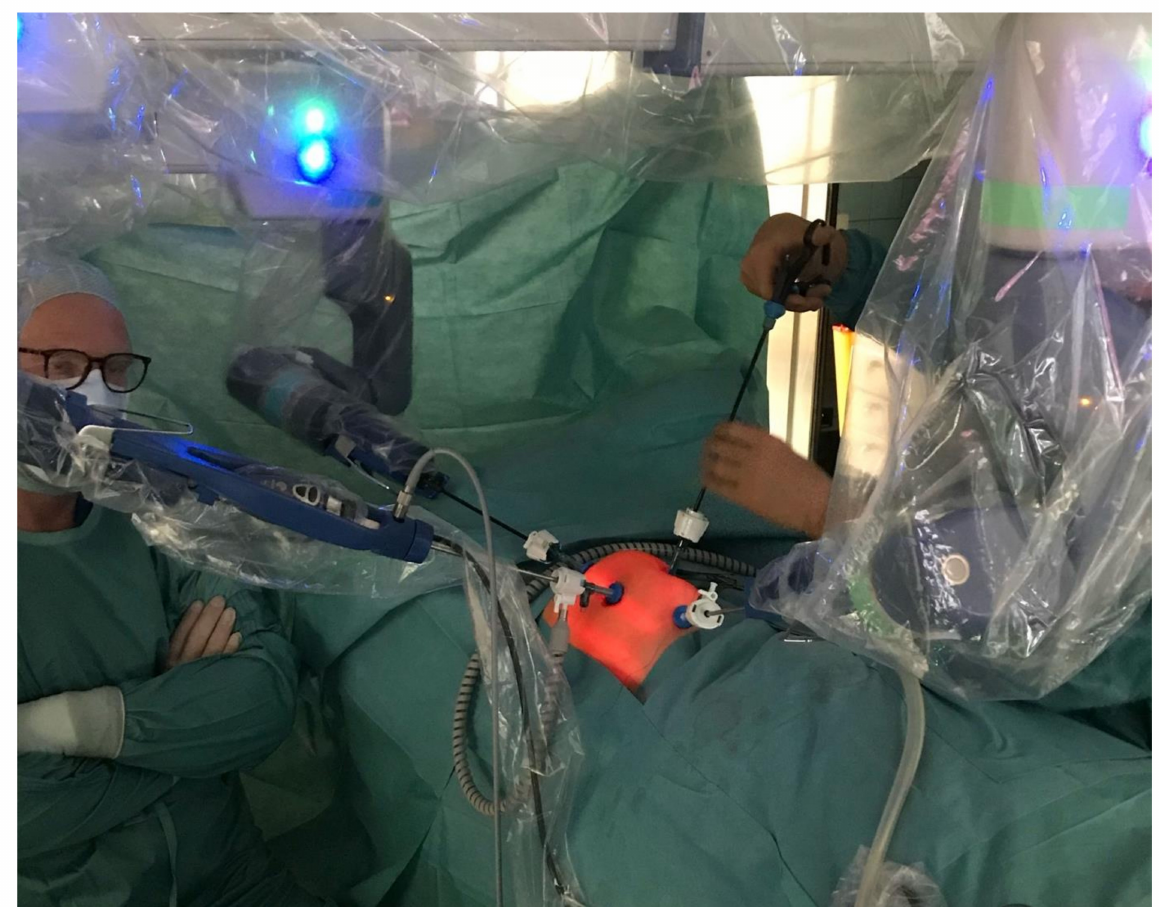
Figure 4. Robotic left sided Anderson–Hynes pyeloplasty (21 January 2021). Robotic arms have been docked (blue docking adapters) to the camera and two instruments; one auxiliary port is placed in the left hypogastric abdomen. Note the camera arm working “overhead” from the patient’s right side with the robot arm base being placed on the patient’s left side (see Figure